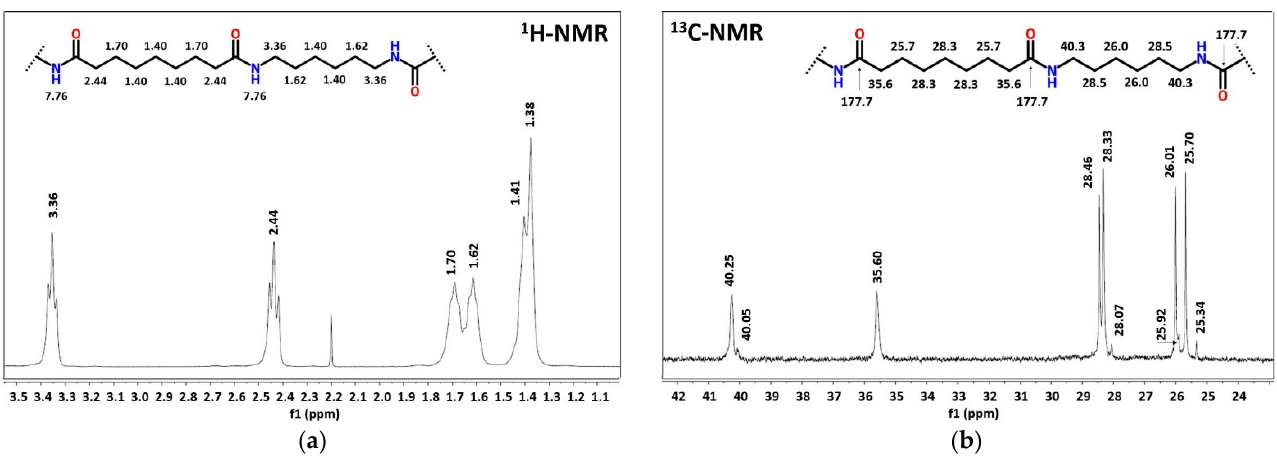
Figure 4. NMR spectrum of PA6.9 (in DCOOD) with interpretation of chemical shifts, 1 H-NMR spectrum ( a ) and 13 C-NMR spectrum ( b ).